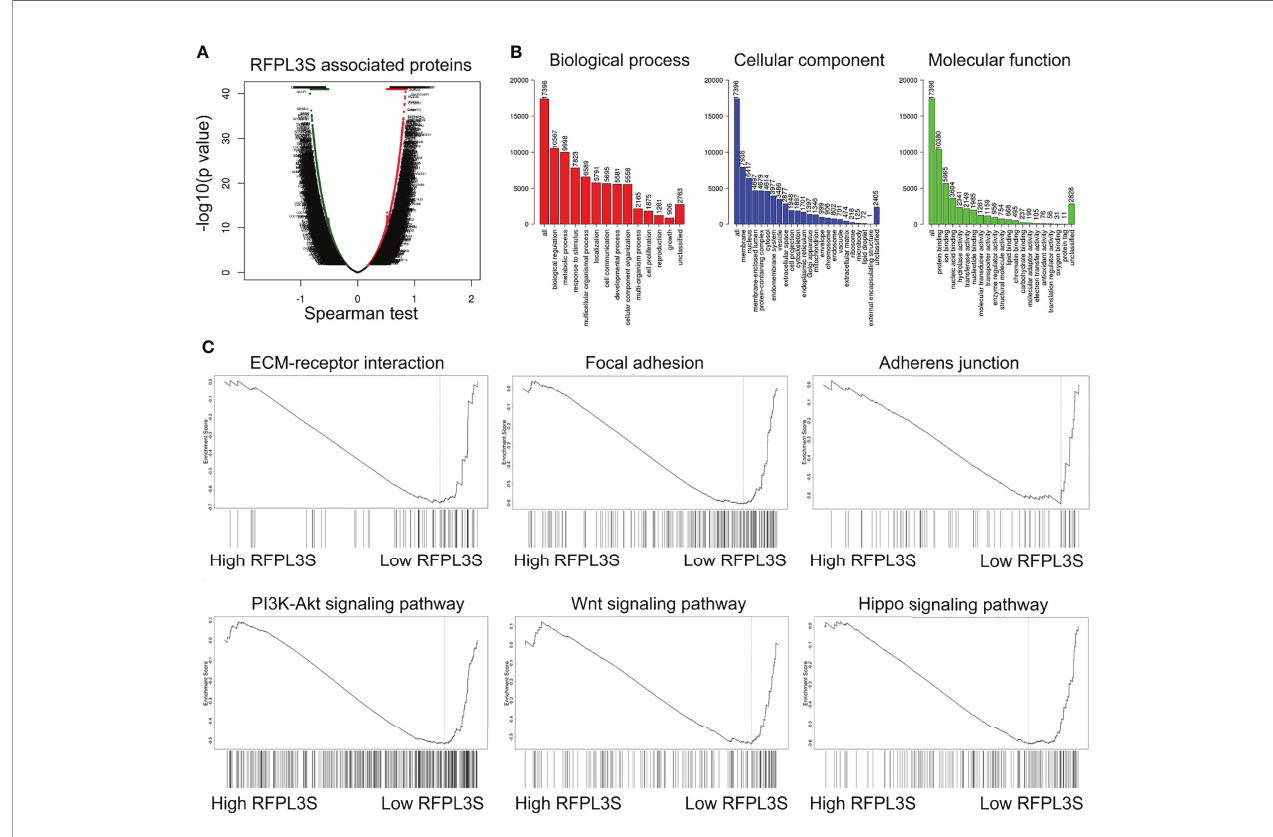
FIGURE 4 | GSEA analysis for the regulatory signaling pathway of RFPL3S. Based on the TCGA TGCT expression pro fi le data, LinkedOmics (http://www. linkedomics.org/login.ph) was used to analyze the co-expressed genes of RFPL3S (A) , GO enrichment analysis (B) , and GSEA enrichment analysis (C)